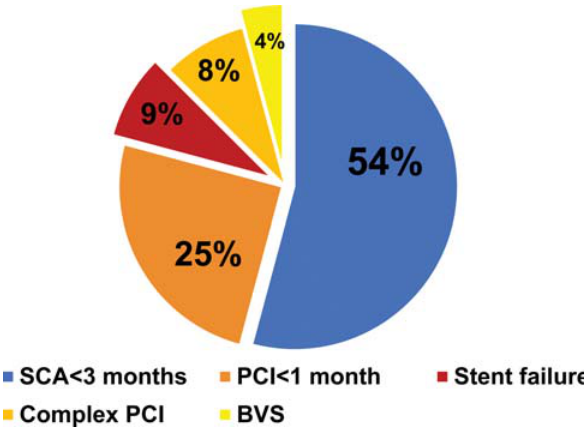
Fig.2 High thrombotic riskcategories included in the studied patient population undergoing to bridging with cangrelor for nondeferrable relevant bleeding risk surgery.